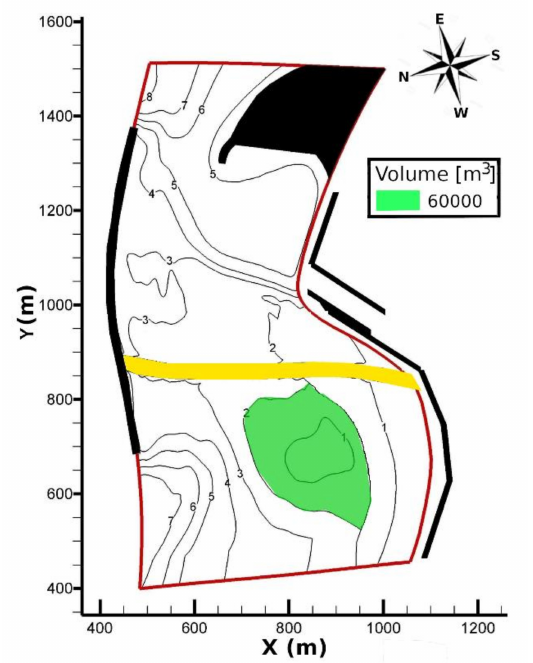
Figure 14. Configuration 2. Accretion areas after three simulated